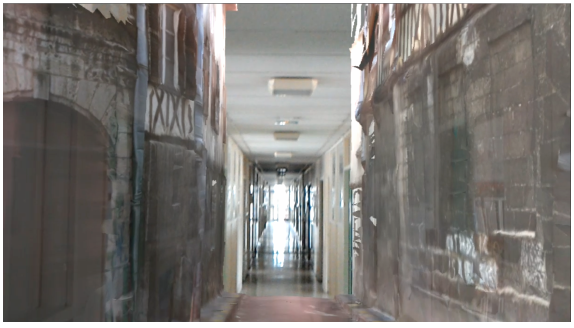
Figure 6. Morphing a street into an indoor corridor.